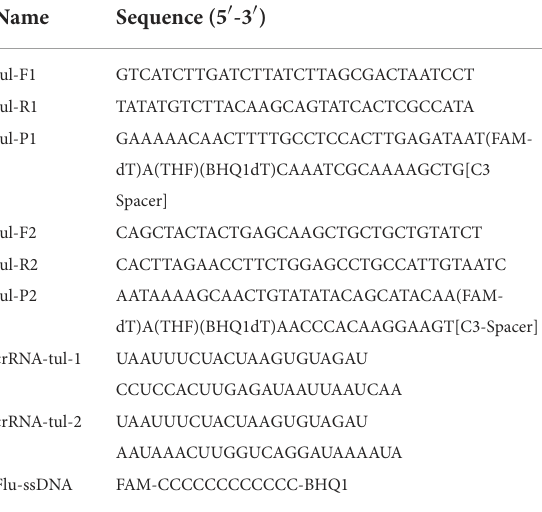
TABLE 1 The involved oligonucleotides